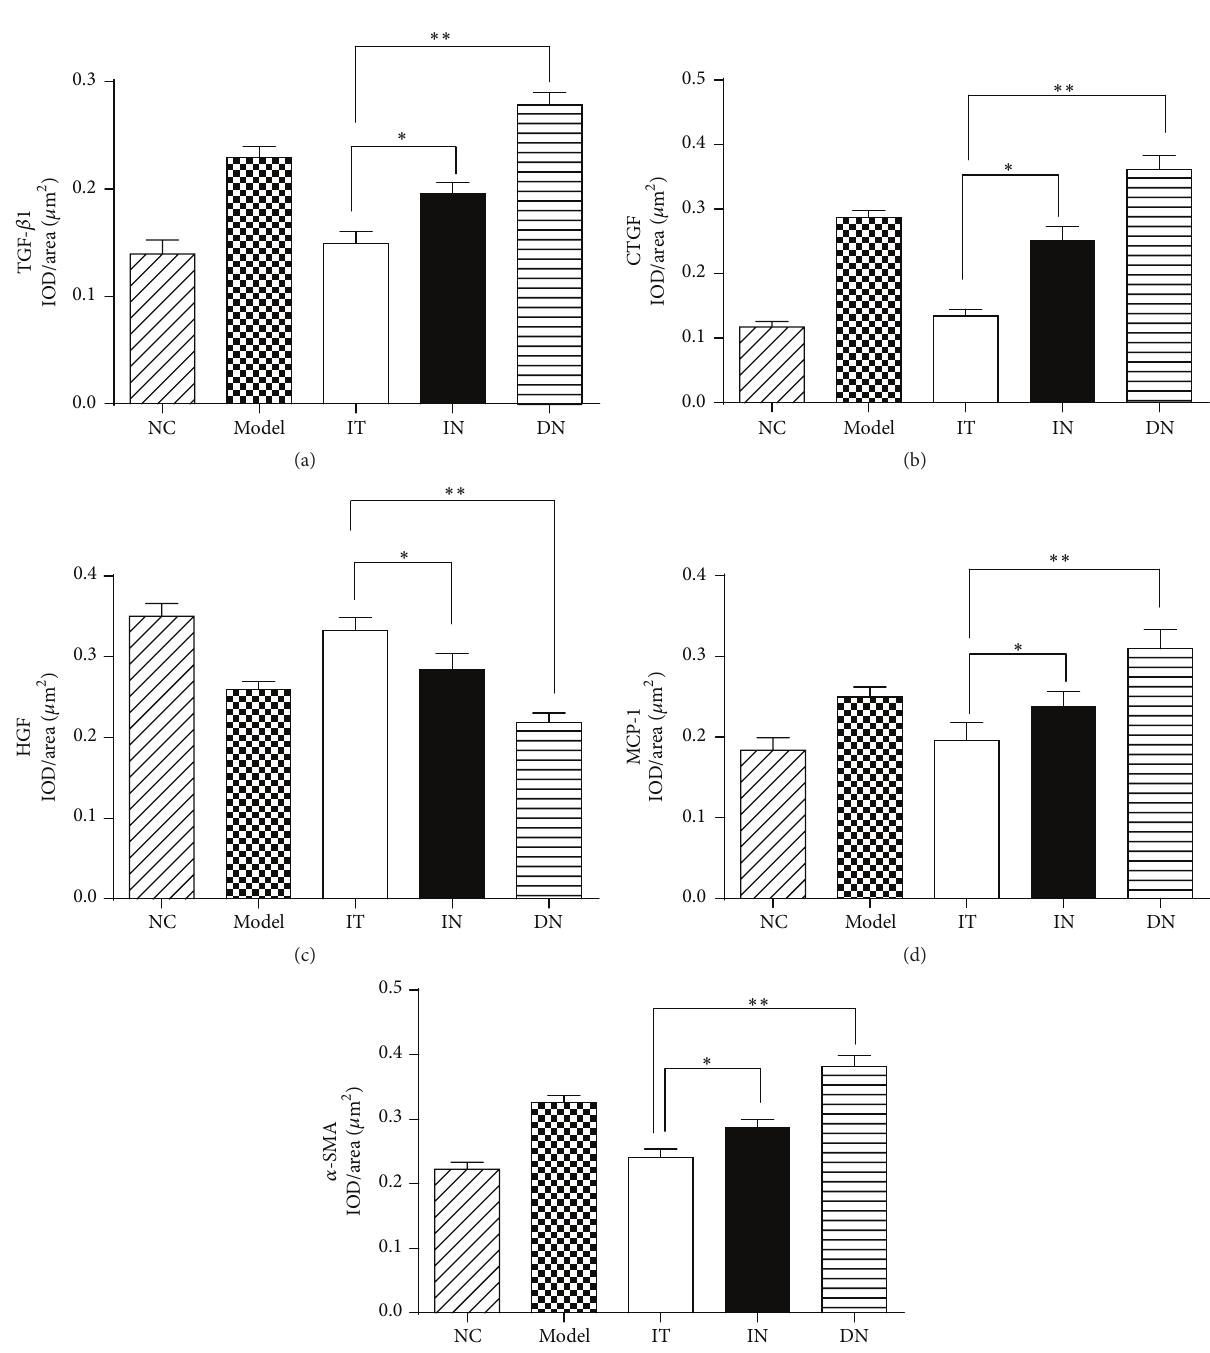
Figure 5: Measurement of IOD/area of immunohistochemical staining of renal fibrogenic and interstitial fibrosis factors. (a) Measurement of IOD/area of TGF- 𝛽 1, ∗ 𝑝 = 0.013 , and ∗∗ 𝑝 < 0.001 . (b) Measurement of IOD/area of CTGF, ∗ 𝑝 = 0.002 and ∗∗ 𝑝 < 0.001 . (c) Measurement of IOD/area of HGF, ∗ 𝑝 = 0.001 and ∗∗ 𝑝 < 0.001 . (d) Measurement of IOD/area of MCP-1, ∗ 𝑝 = 0.001 and ∗∗ 𝑝 < 0.001 . (e) Measurement of IOD/area of 𝛼 -SMA, ∗ 𝑝 = 0.018 and ∗∗ 𝑝 < 0.001 . IOD/area, integrated optical density/area. The mean of IOD/area of positive staining was used to accurately measure the degree of positive expression in immunohistochemical staining. Model group: diabetic nephropathy model rats established at 12